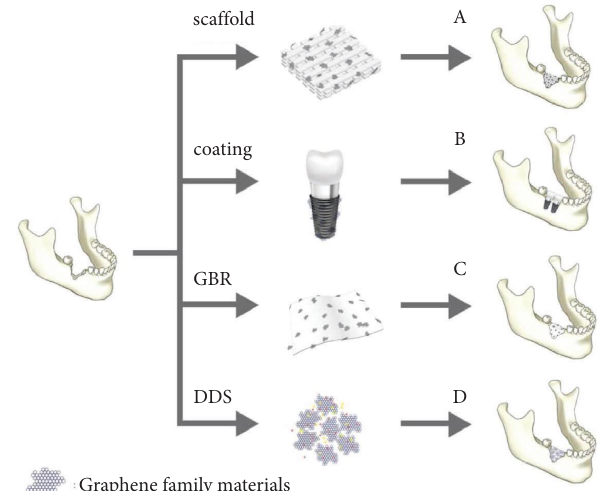
Figure 10: Graphene-based materials used in (A) scafold materials for bone regeneration, (B) coatings on dental implants to promote osseointegration, (C) bone membrane regeneration acting as a guide, and (D) drug delivery systems (DDSs) to induce bone regenerative properties (reprinted from Cheng et al. [112]